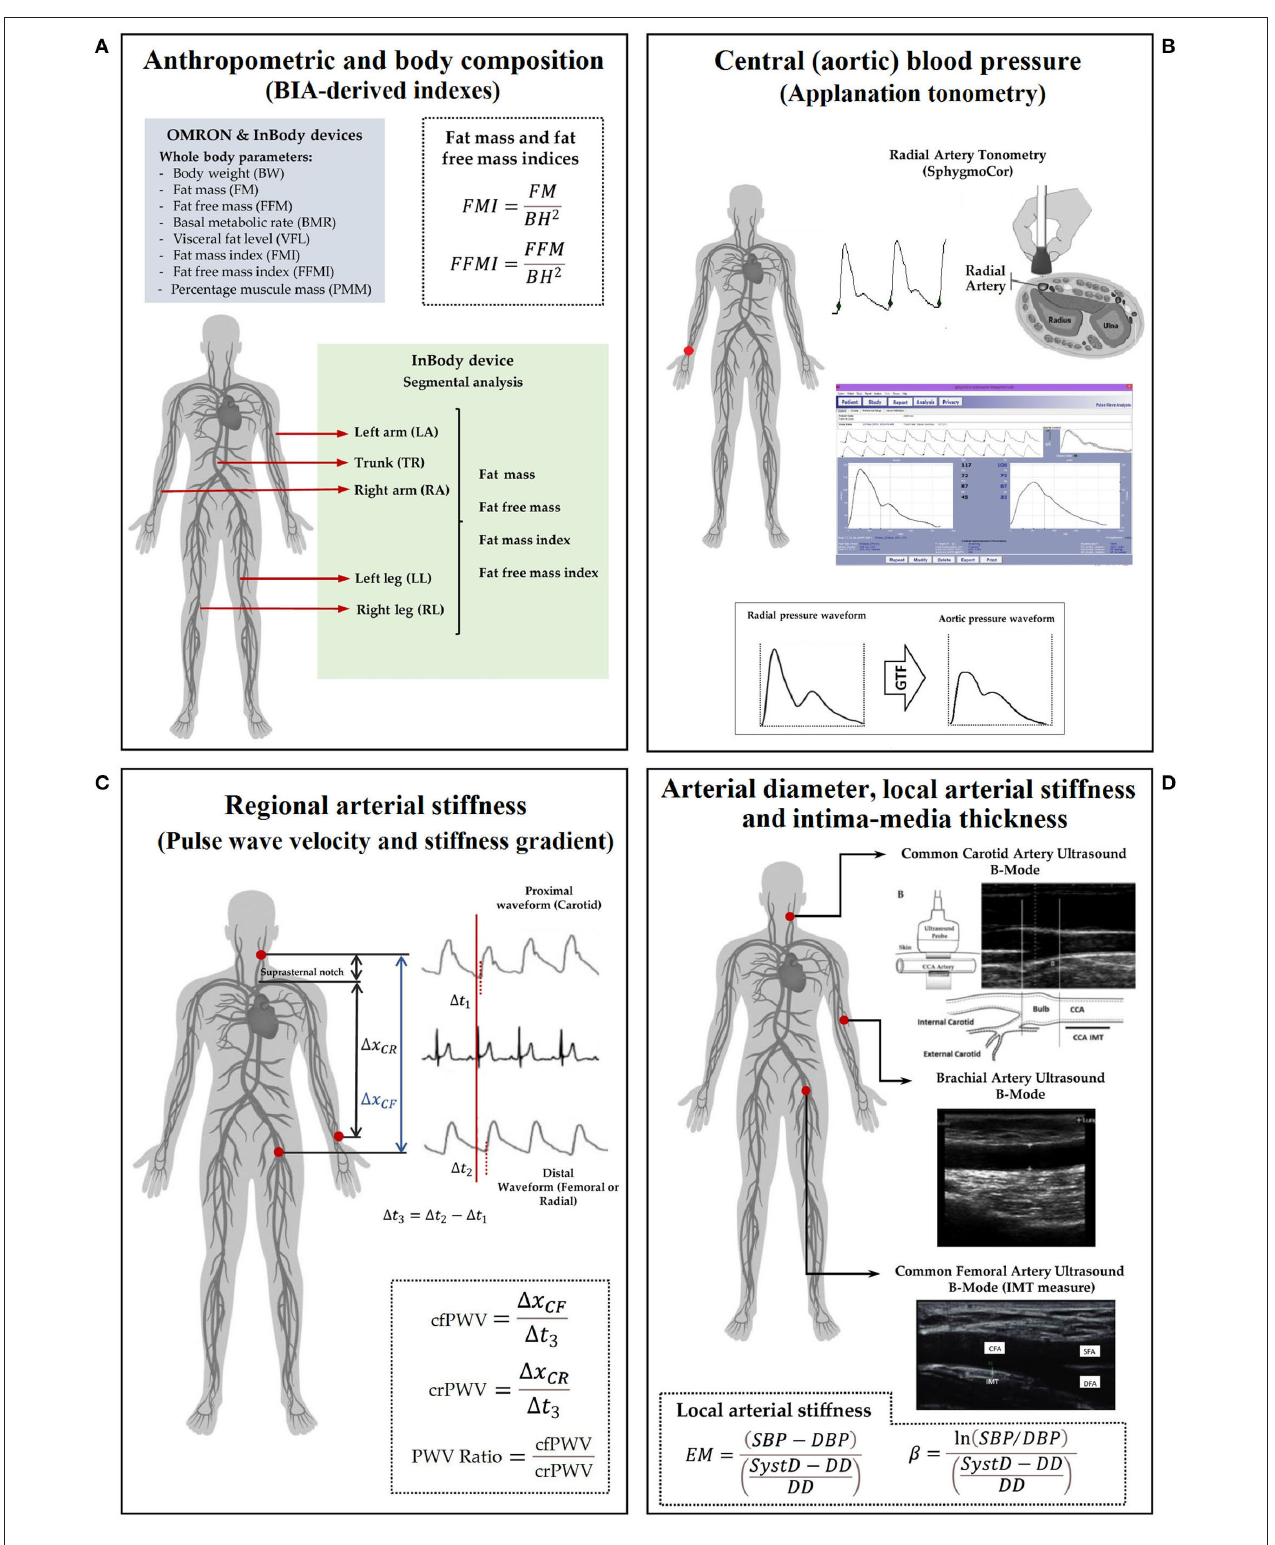
FIGURE 1 | A measurement scheme. Left to right, top to bottom. (A) anthropometric evaluation using OMRON HBF-514C (OM) and InBody-120 (IB); (B) central and peripheral blood pressure evaluation; (C) regional arterial stiffness: PWV (cfPWV and crPWV) and PWV ratio; (D) arterial diameter, IMT, and local arterial stiffness. Abbreviations as in